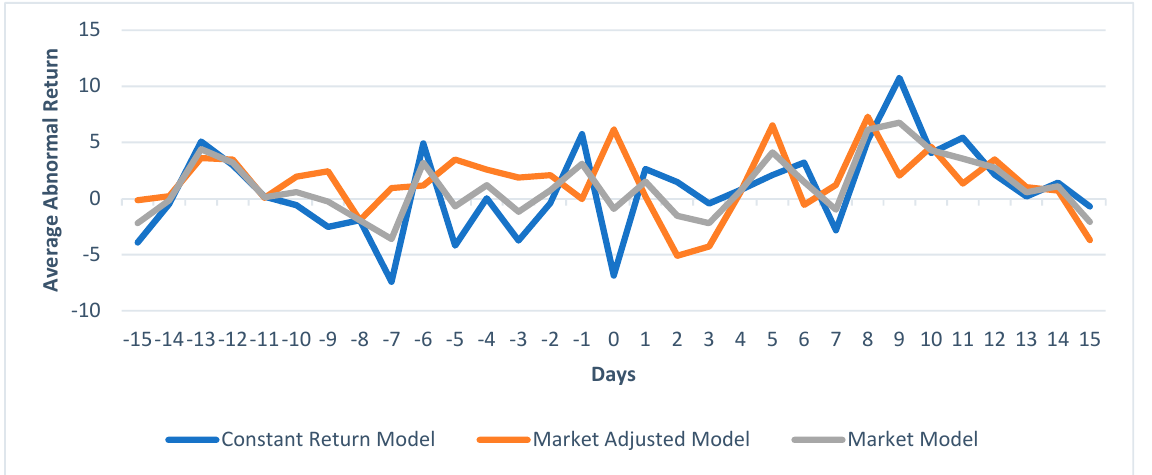
Figure 3. Event period AAR for the pharma sector (source: the authors). Similarly, Figure 4 highlights that the market adjusted model recorded positive returns for the consumer goods sector. Even after the adverse impacts of the lockdown and the prevailing uncertainties, the consumption stocks did not see a sharp decline. This is because (i) essential commodities are inelastic and their demand and supply would not decline even under these circumstances, and (ii) the consumer sector demonstrated low operational fragility and the market value did not face a severe blow during the crisis (Verma et al. 2021).